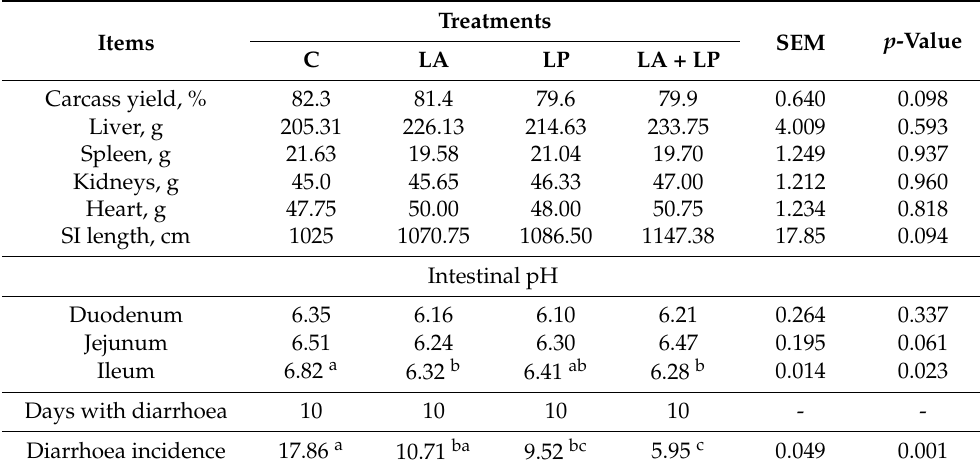
Table 3. Effect of microencapsulated probiotics supplements on organ development, intestinal pH and diarrhoea incidence of weaning piglets.